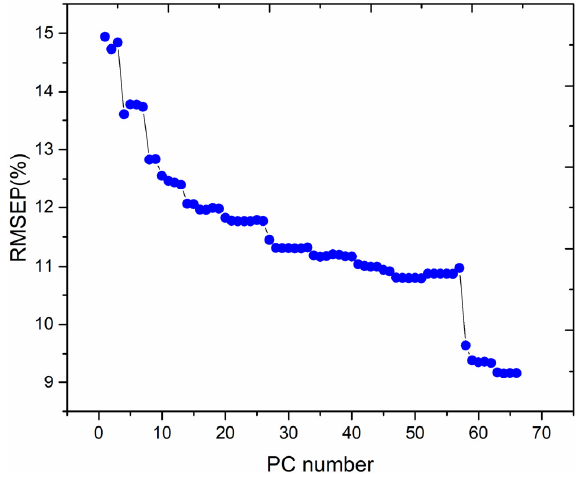
Figure 4. Effect of the number of PCs on the performance of the PLSR quantitative analysis model. From Figure 4, the RMSEP of the training set fluctuates with the increase in PC num- ber, exhibiting a general decreasing trend. When the number of PC is 64, the lowest